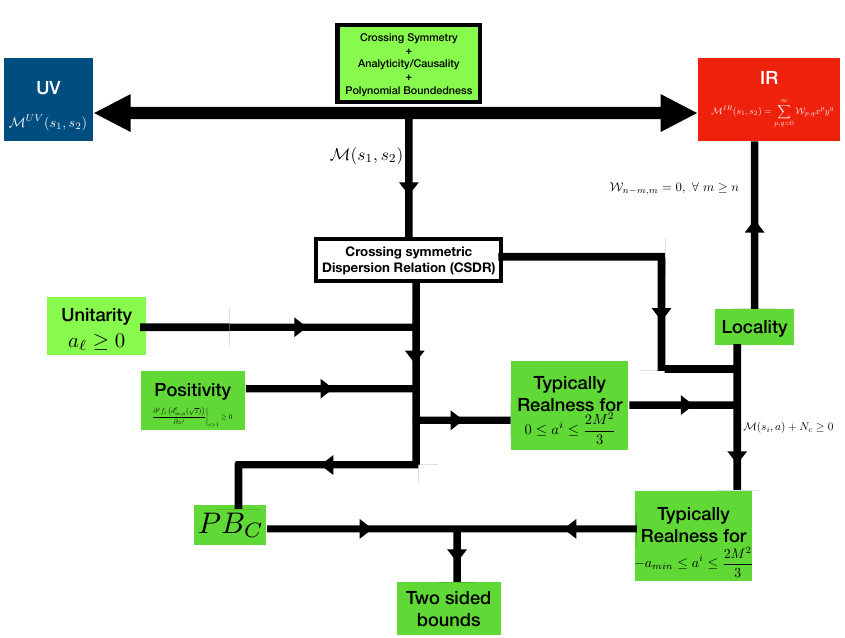
Figure 1: The above flowchart shows the steps involved in the GFT